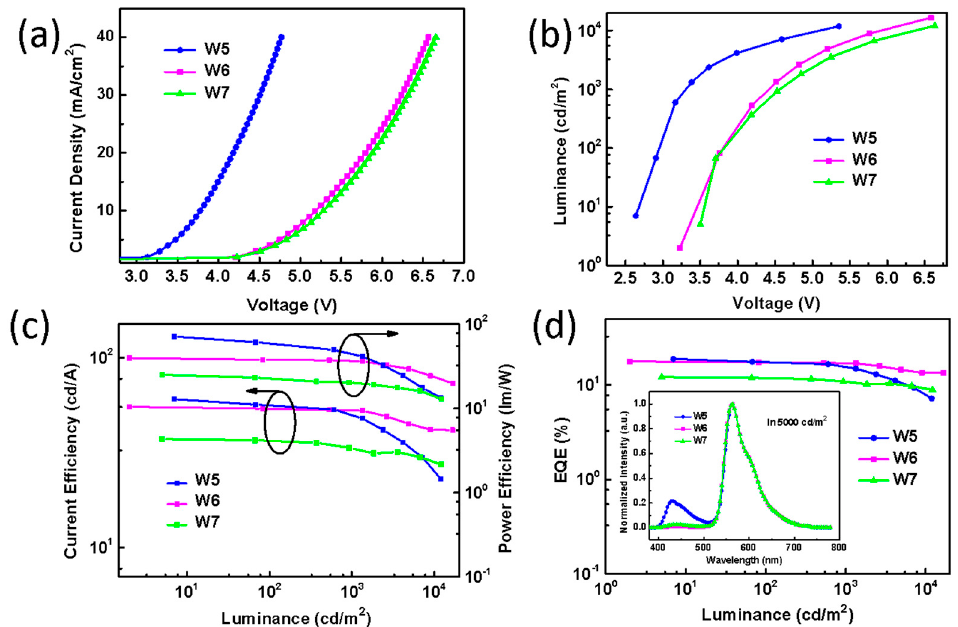
Figure 5. ( a ) The current density–voltage curves of W5 (4P-NPD), W6 (CBP), W7 (mCP). ( b ) Luminance- voltage curves of W5, W6, W7. ( c ) The current e ffi ciency–luminance–power e ffi ciency characteristics of them. ( d ) EQE: the luminance characteristics. Inset: EL spectra of W5, W6, W7 at the luminance of 5000 cd / m 2 .